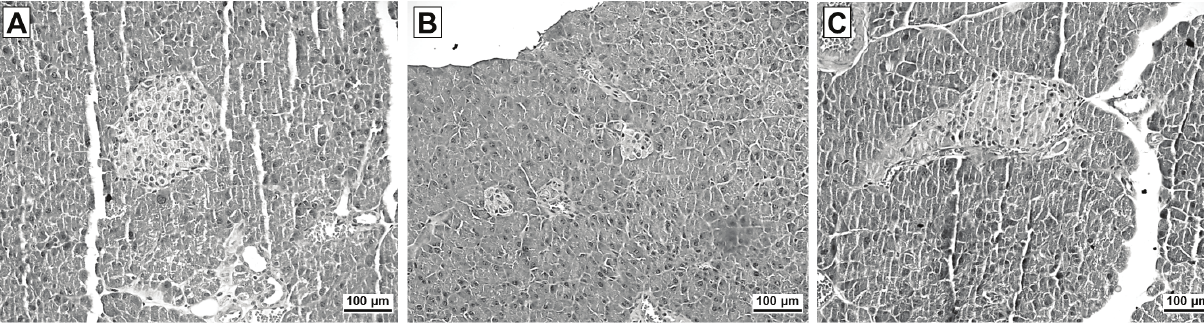
Experimental groups (n=10/group)